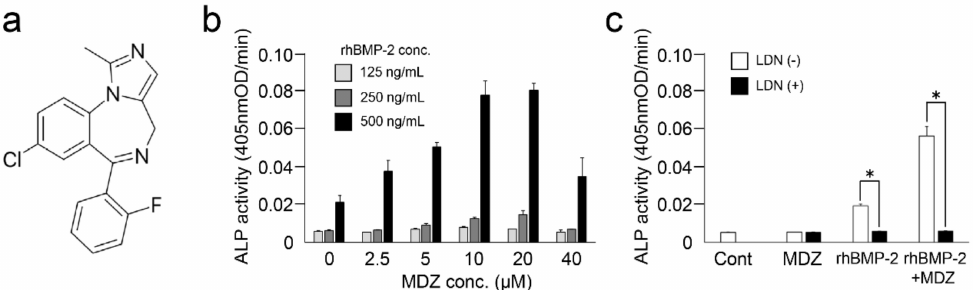
Figure 1. Combined e ff ect of midazolam (MDZ) and bone morphogenetic protein-2 (BMP-2) on alkaline phosphatase (ALP) activity in C2C12 cells: ( a ) Structure of MDZ; ( b ) ALP-inducing activity of MDZ (0, 2.5, 5, 10, 20, and 40 µ M) with recombinant human (rh)BMP-2 (125, 250, and 500 ng / mL); ( c ) inhibition experiment of ALP-inducing activity in the absence of rhBMP-2 and MDZ (Cont) or presence of 20 µ M MDZ alone (MDZ), 500 ng / mL rhBMP-2 alone (rhBMP-2), and the combination of rhBMP-2 and MDZ (rhBMP-2 + MDZ) containing 50 nM LDN-193189 (LDN). Values are the means ± standard error of the